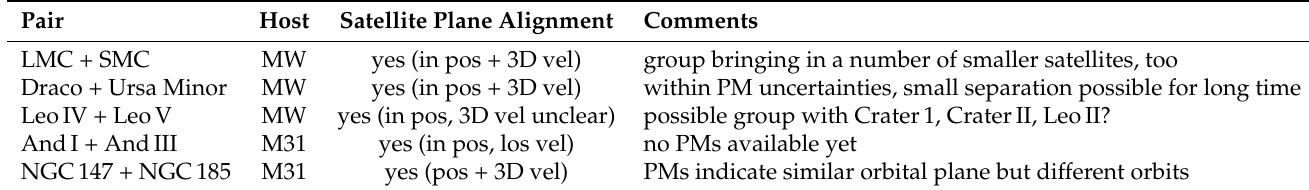
Table 2. Proposed pairs of satellite galaxies in the Local